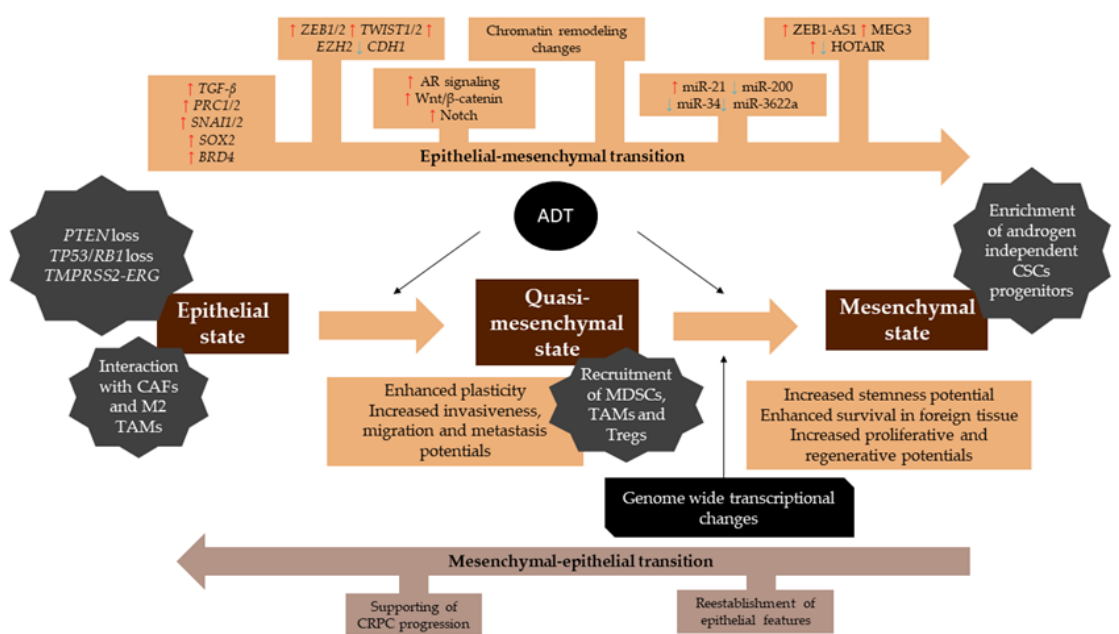
Figure 1. Processes and molecular events involved in EMT in prostate cancer. Tumor cells in an epithelial state gain internal and external stimuli to restore the EMT programming. EMT promotes wide transcriptional changes, illustrated at the top. Red arrows indicate upregulated genes, pathways and noncoding RNAs during EMT, blue arrows indicate the ones that are downregulated during this process. The quasi-mesenchymal state is the state of most of the cells affected by EMT, as shown in the center of the figure. At this stage, cells have enhanced plasticity and increased progression features. Quasi-mesenchymal cells modulate the tumor microenvironment, expressing immune evasion-related cytokines and recruiting immunosuppressive cells, which enhances an immunological evasion phenotype. Cells undergoing EMT confer a selective advantage when patients undergo antiandrogen therapy, enriching androgen-independent CSC progenitors. In the mesenchymal state, cells are usually resistant to therapy and have increased stemness and survival potentials. The mesenchymal–epithelial transition is established to restore epithelial features and support castrate-resistant prostate cancer (CRPC) growth. CAFs—cancer-associated fibroblasts, TAMs—tumor-associated macrophages, MDSCs—myeloid-derived suppressor cells, CSCs—cancer stem cells.